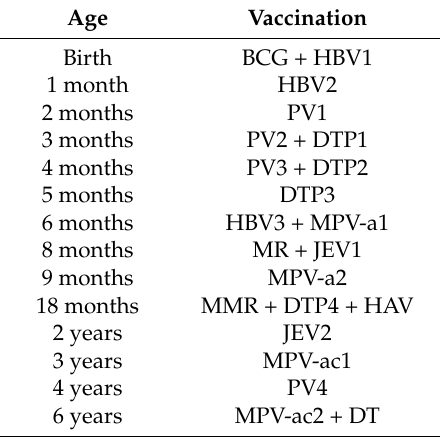
Table 1. Chinese childhood vaccination schedule up to six years of age. Age Vaccination Birth BCG +